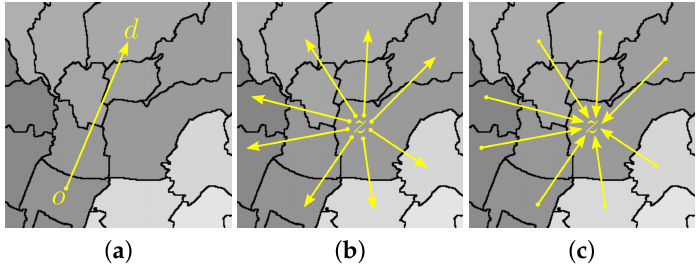
Figure 3. Example of mobility demand relations: ( a ) one-to-one relation between an ori- demand attracted by a generic zone z . Size of the crop area: 3 km ˆ 3